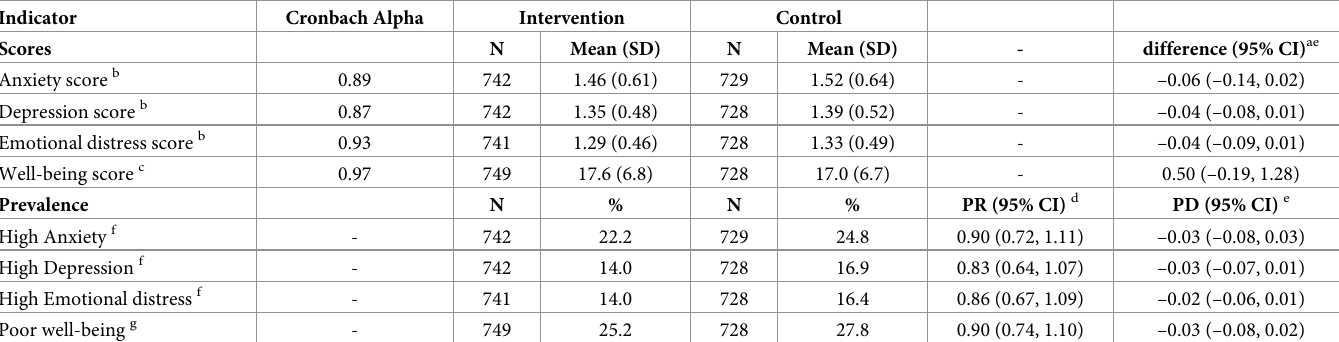
Table 2. Mental well-being outcomes at